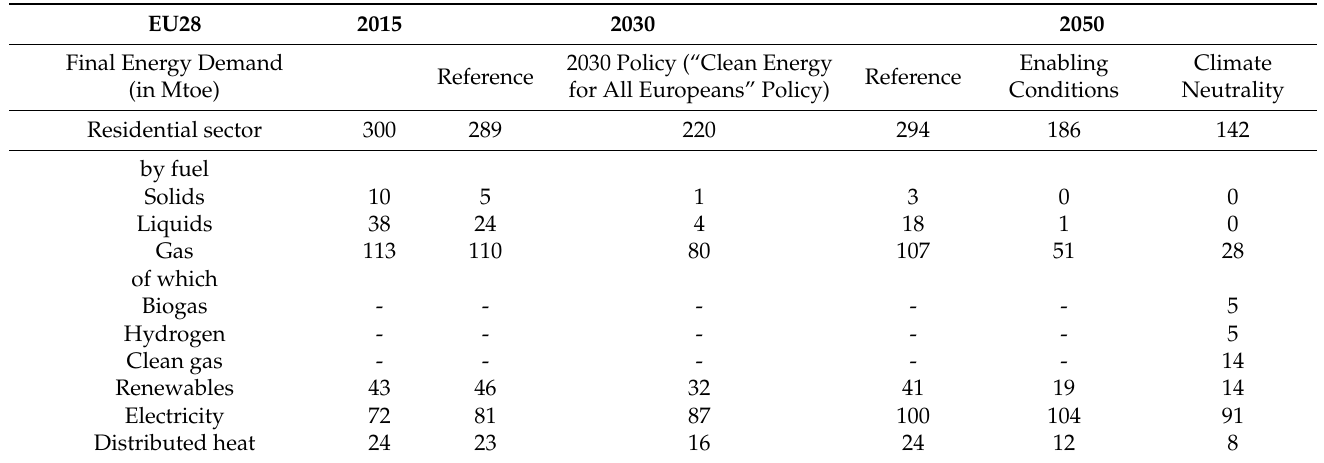
Table 4. Final energy demand by fuel in the residential sector in the